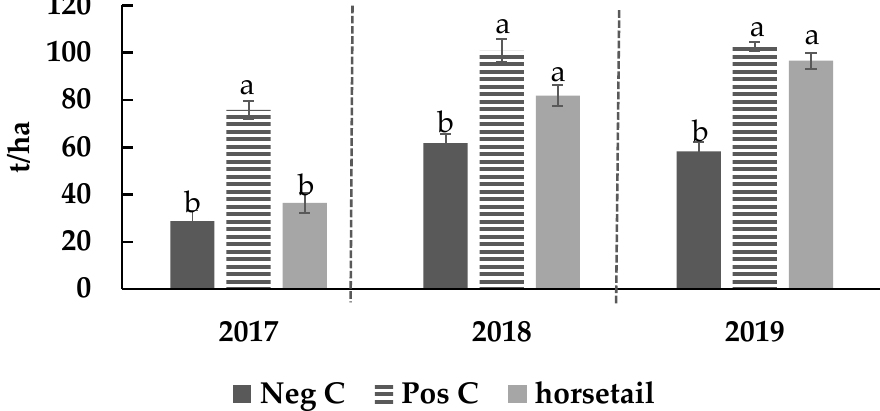
Figure 3. Tomato yield in Cu (positive C) and horsetail macerate treatments compared with un-